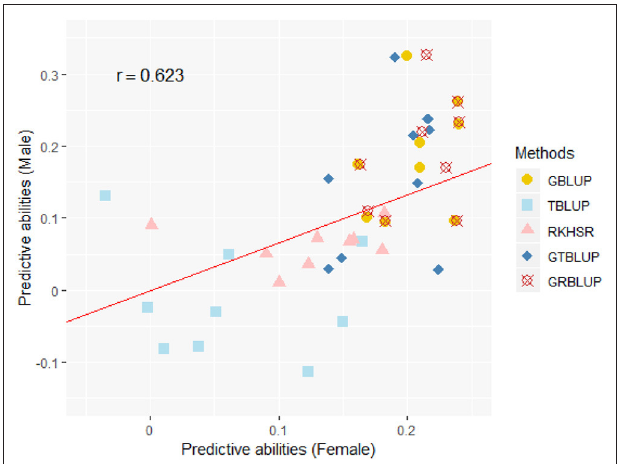
FIGURE 3 | The correlation between predictive abilities in females and males across nine traits and five statistical models. r denotes the Pearson correlation coefficient between female and male predictive abilities across all traits and all statistical models. The red line denotes a standardized major axis regression line.